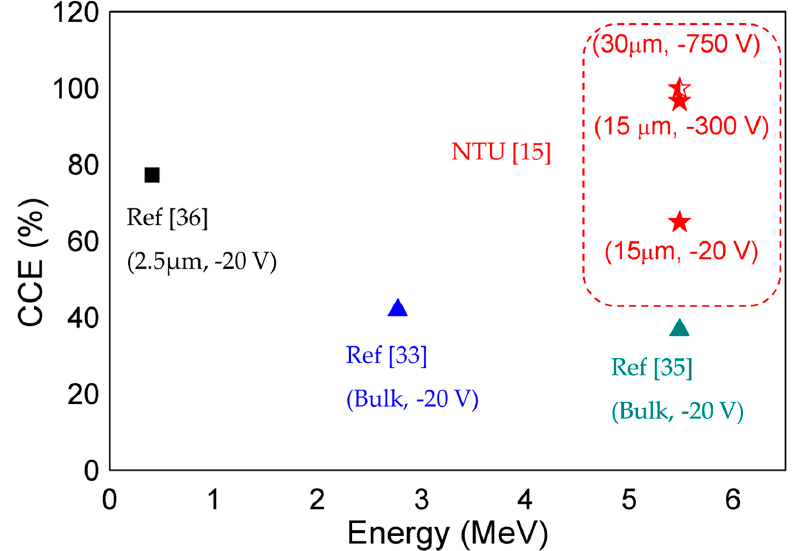
Figure 21. Benchmarking of extracted CCE of compensated detectors with epitaxial-grown GaN detectors (squares) and bulk GaN detectors (triangles) at low voltages.